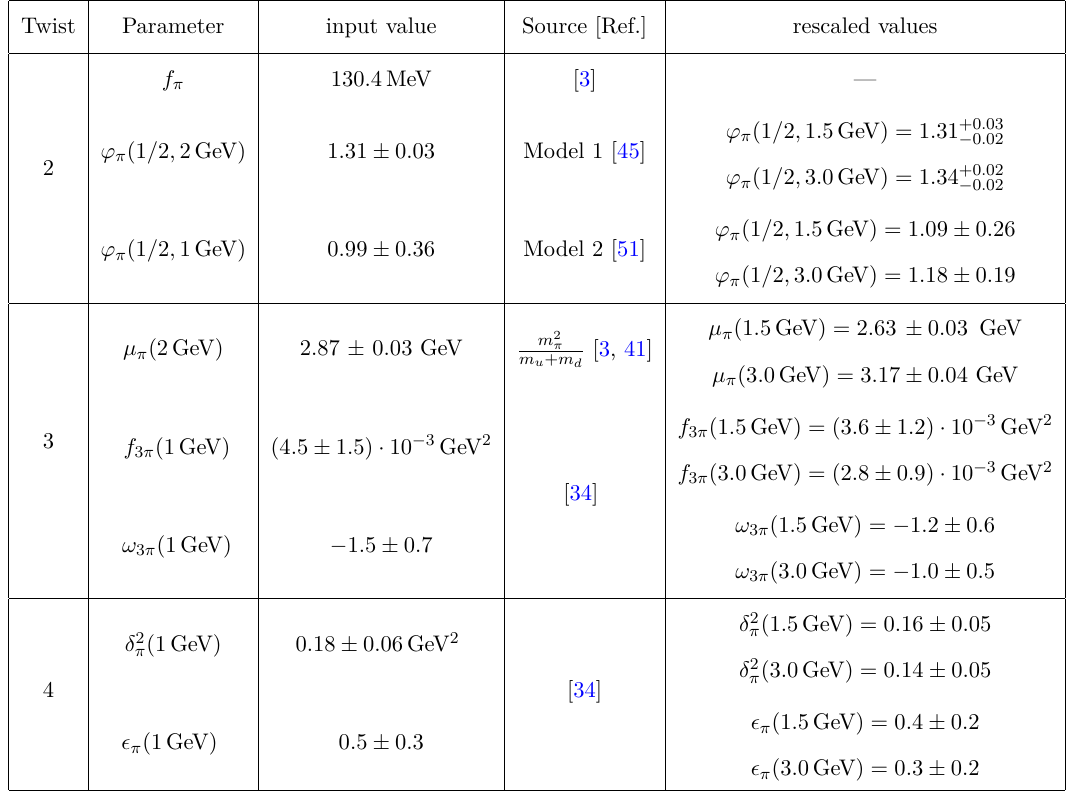
Table 2 . Parameters of pion